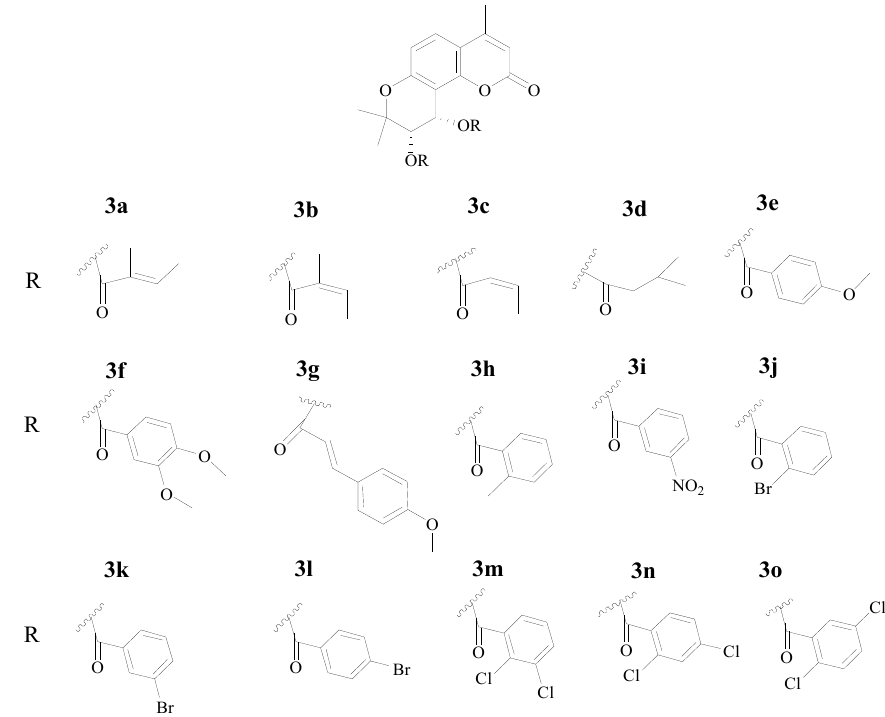
Figure 2. Structures of 4-methyl-(3' S ,4' S )- cis -khellactone derivatives 3a – o